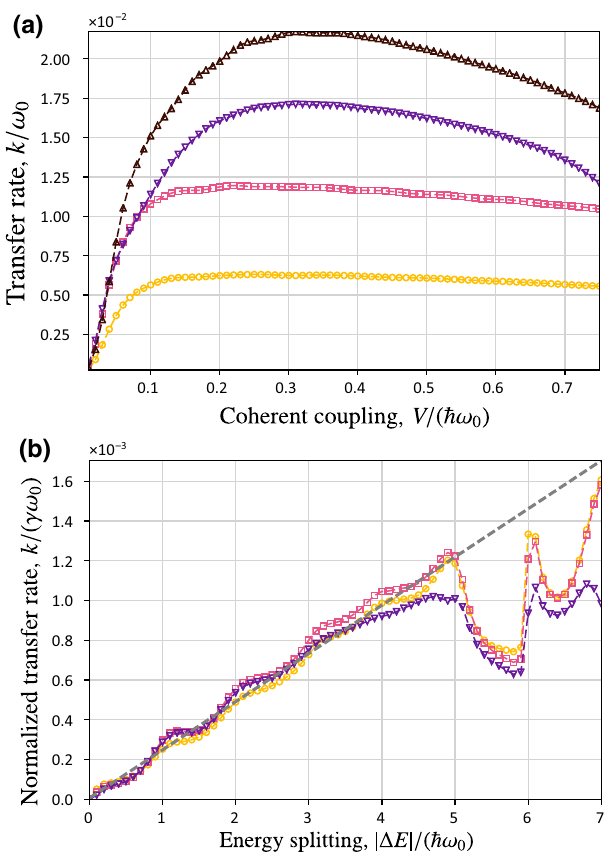
FIG. 5. The properties of the transfer rate in the quantum adi- abatic limit. (a) The quantum ET rates as a function of the electronic coupling V for | (cid:2) E | = 2 (cid:2) ω 0 (yellow circles), | (cid:2) E | = 4 (cid:2) ω 0 (pink squares), | (cid:2) E | = 6 (cid:2) ω 0 (violet lower triangles), and | (cid:2) E | = 8 (cid:2) ω 0 (black upper triangles). (b) The quantum ET rates divided by the cooling rate γ , as a function of the donor-acceptor energy gap (cid:2) E , for V = 0.75 (cid:2) ω 0 and γ = 0.025 ω 0 / 2 π (yellow circles), γ = 0.05 ω 0 / 2 π (pink squares), and γ = 0.075 ω 0 / 2 π (violet lower triangles). The rates in the normal regime ( | (cid:2) E | < 5 (cid:2) ω 0 ) approximately follow the quantum adiabatic limit given in Eq. (6), which predicts a linear dependence on | (cid:2) E | (since the latter controls the resonantly coupled phonon number ν ). For | (cid:2) E | > 5 (cid:2) ω 0 , the process is no longer purely quantum adi- abatic due to the trapping of part of the initial population in the upper adiabatic BO surface (see the text). The dashed line shows a linear fit, a | (cid:2) E | /( (cid:2) ω 0 ) + b , with a = 2.4 × 10 − 4 γ ω 0 and b = 5.2 × 10 − 6 γ ω 0 . All remaining parameters are chosen as in Fig.